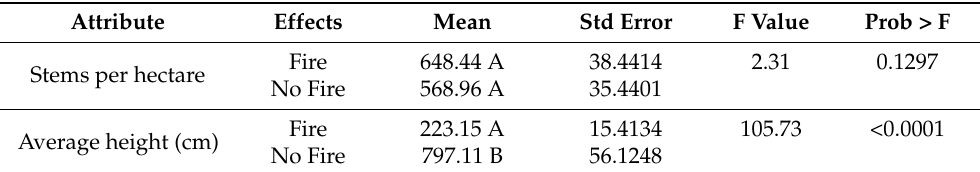
Table 1. Analysis of the mean 1 number of paulownia ( Paulownia tomentosa ) stems per hectare and the average height in the burned and unburned areas of the 2009 wildfire in Shawnee State Forest, Ohio.